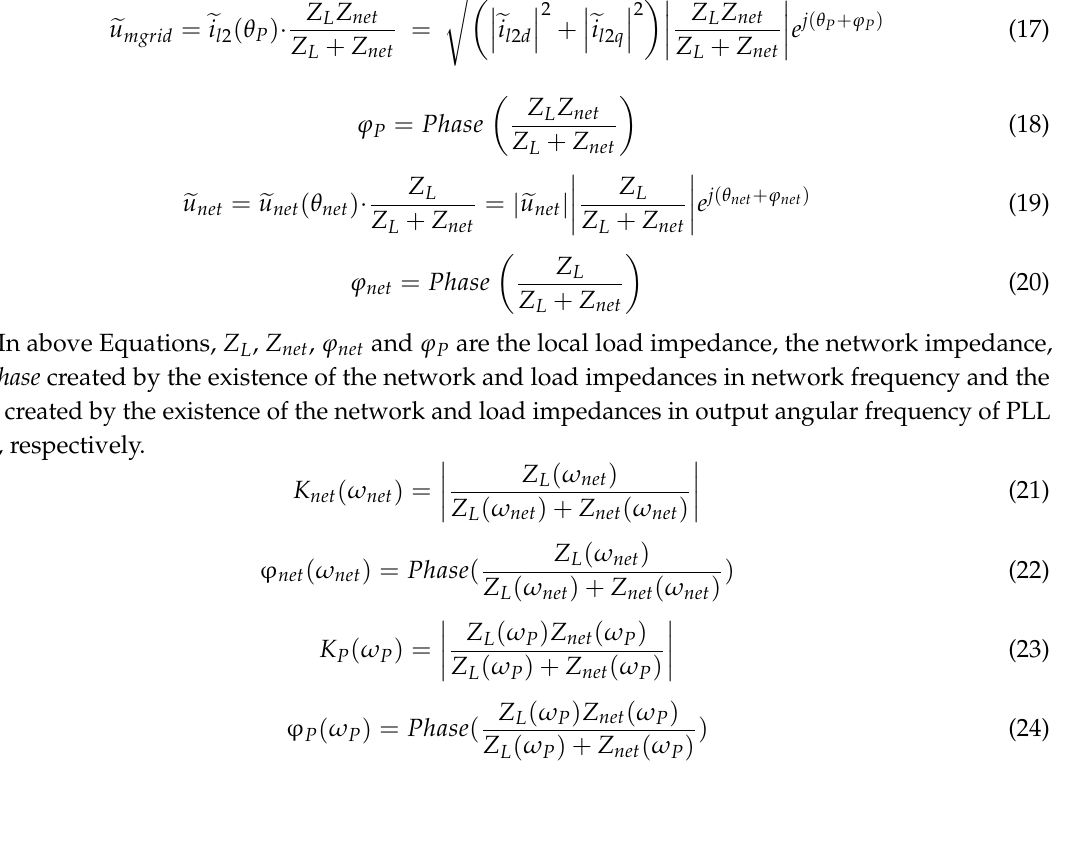
Figure 6. Diagram of network voltage and measured voltage by PLL.